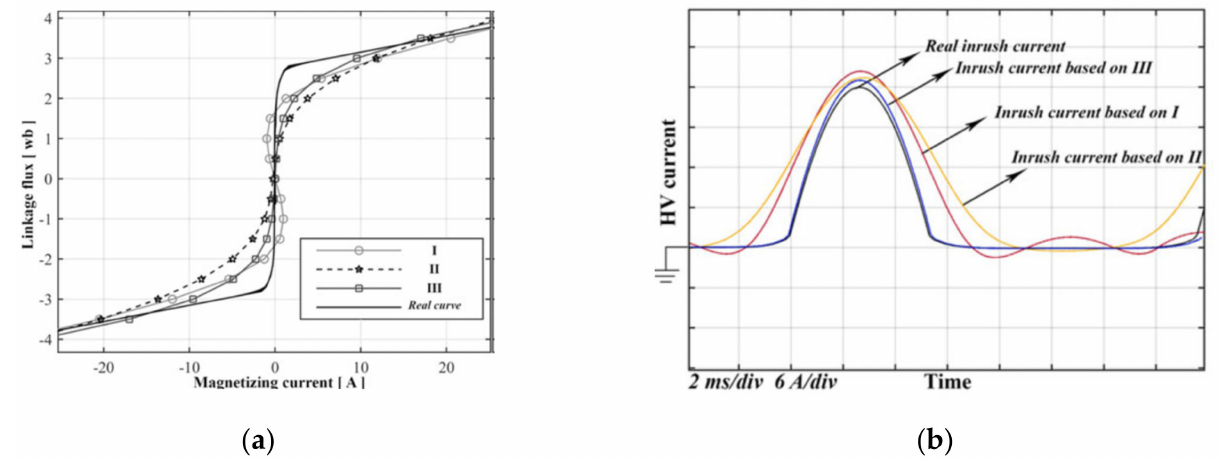
Figure 2. Various estimated magnetization curves ( a ) with their respective inrush currents ( b